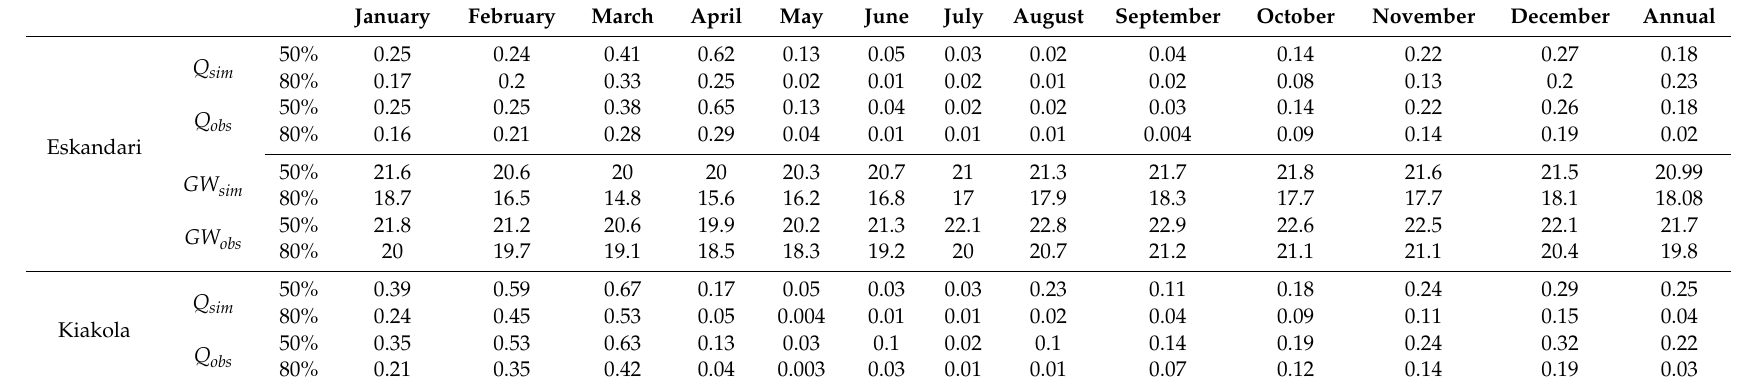
Table A2. Comparison of 50th and 80th percentile of the duration curves of flow discharge and groundwater (Eskandari